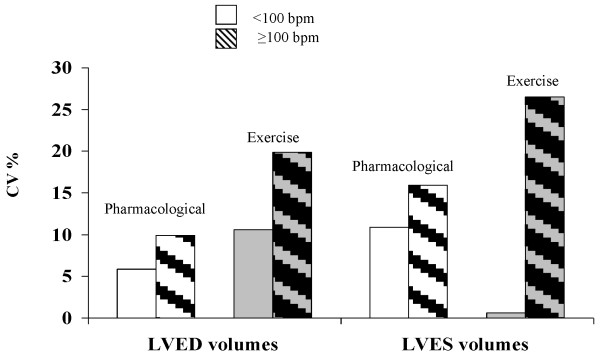
Coefficient of variation for LV ED and ES volumes in pharmacological and exercise stress at different heart rate values at peak stress.